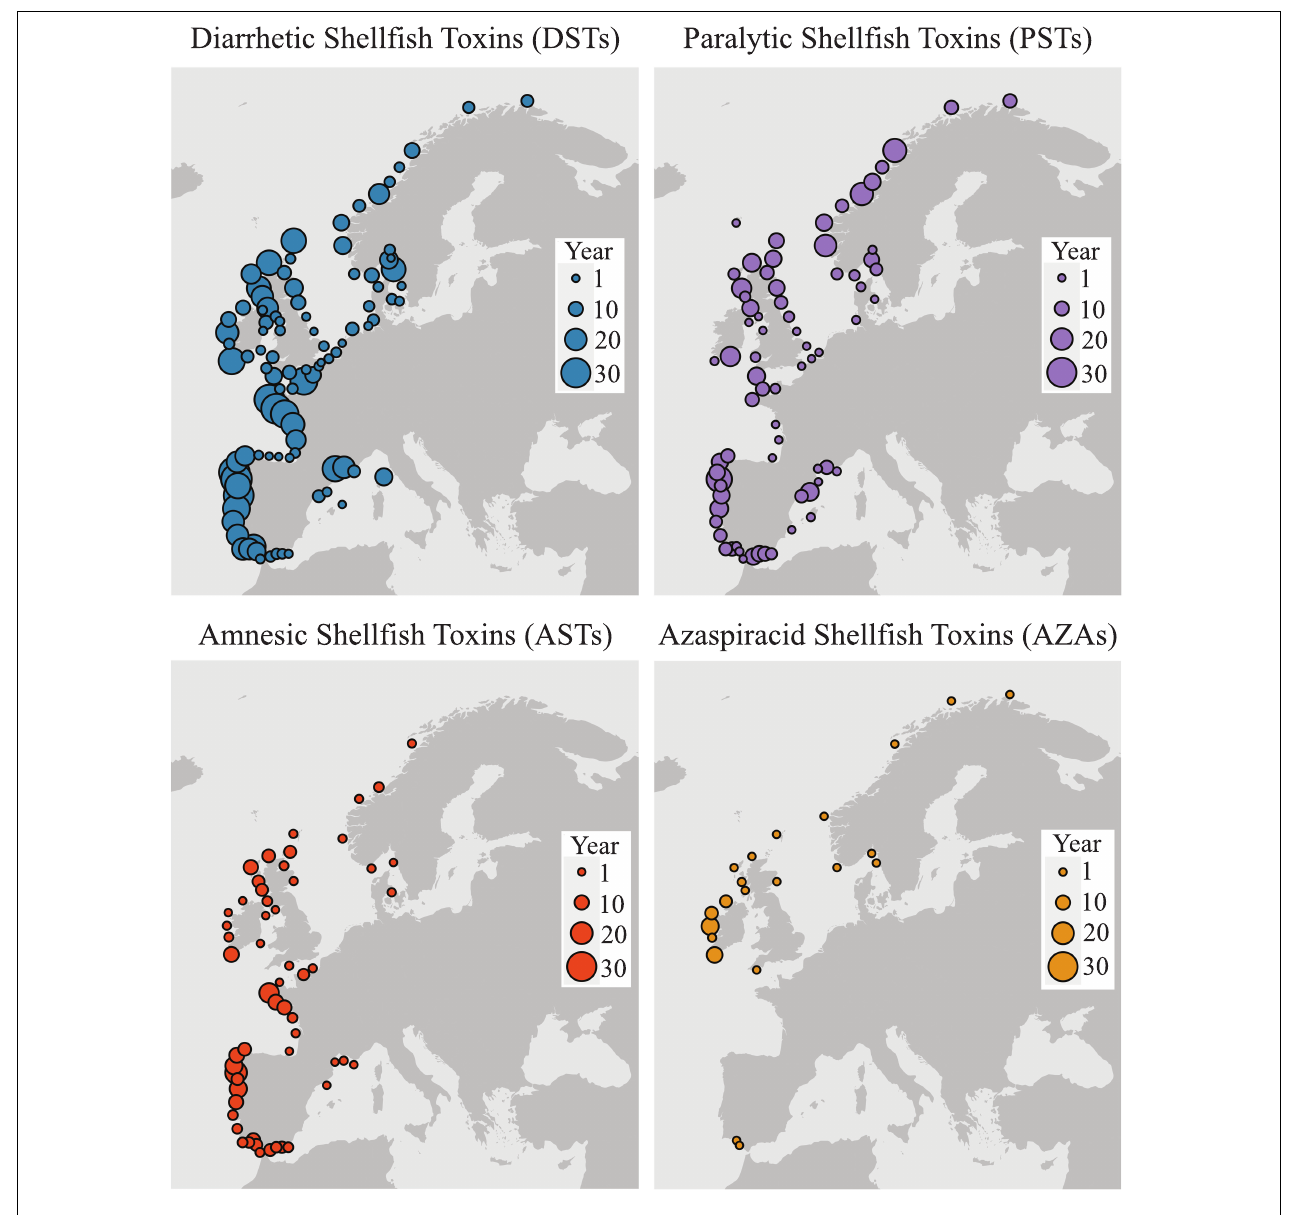
FIGURE 2 | Number of years where events associated with harmful algae have been recorded in IOC-ICES-PICES HAEDAT database. The majority of events are management actions closing shellfish harvesting areas to protect human